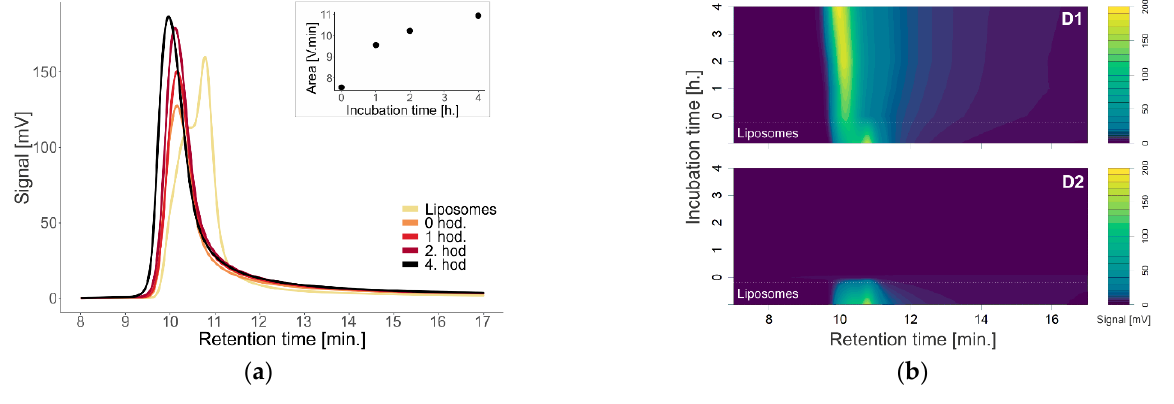
Figure 3. ( a ) Absorption chromatograms of liposomes depending on the time of incubation of added dendron with liposomes at temperature of 37 °C. The nested graph shows the area under the peak of liposomes with dendrons at the corresponding time point. ( b ) Contour plots of liposome absorbance at different incubation times of dendrons with liposomes, top—first-generation dendron; bottom—second-generation dendron.